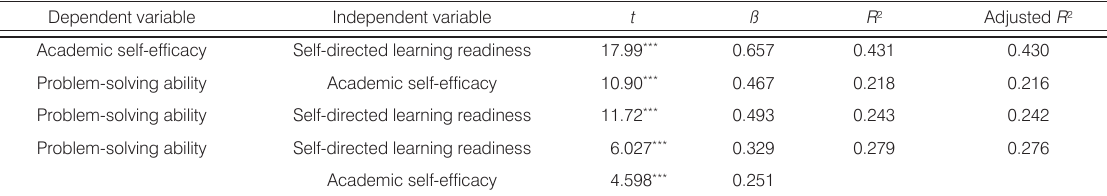
Table 3. Mediating effect of academic self-efficacy on the relationship between self-directed learning readiness and problem-solving ability (N = 429) Note: ***P < 0.001.